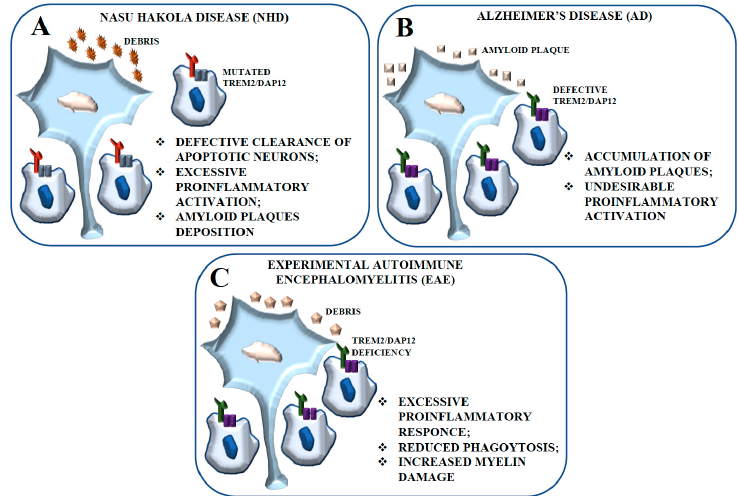
Figure 2. Schematic representation of the contribution of the TREM2-DAP12 pathway to NHD, AD, and Experimental Autoimmune Encephalomyelitis (EAE). ( A ) The defective expression of TREM2 and